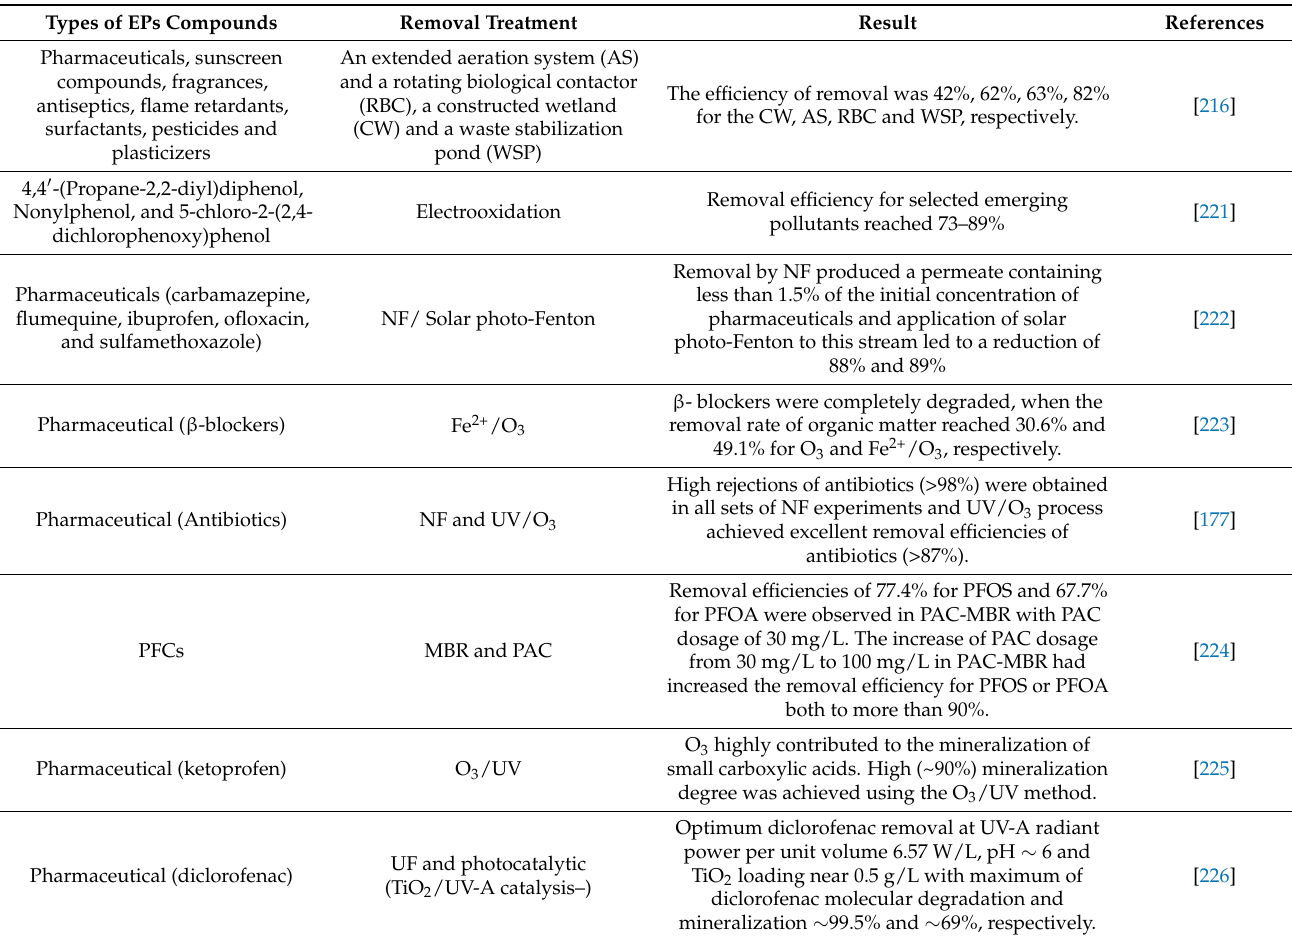
Table 5. Treatment processes for removing emerging